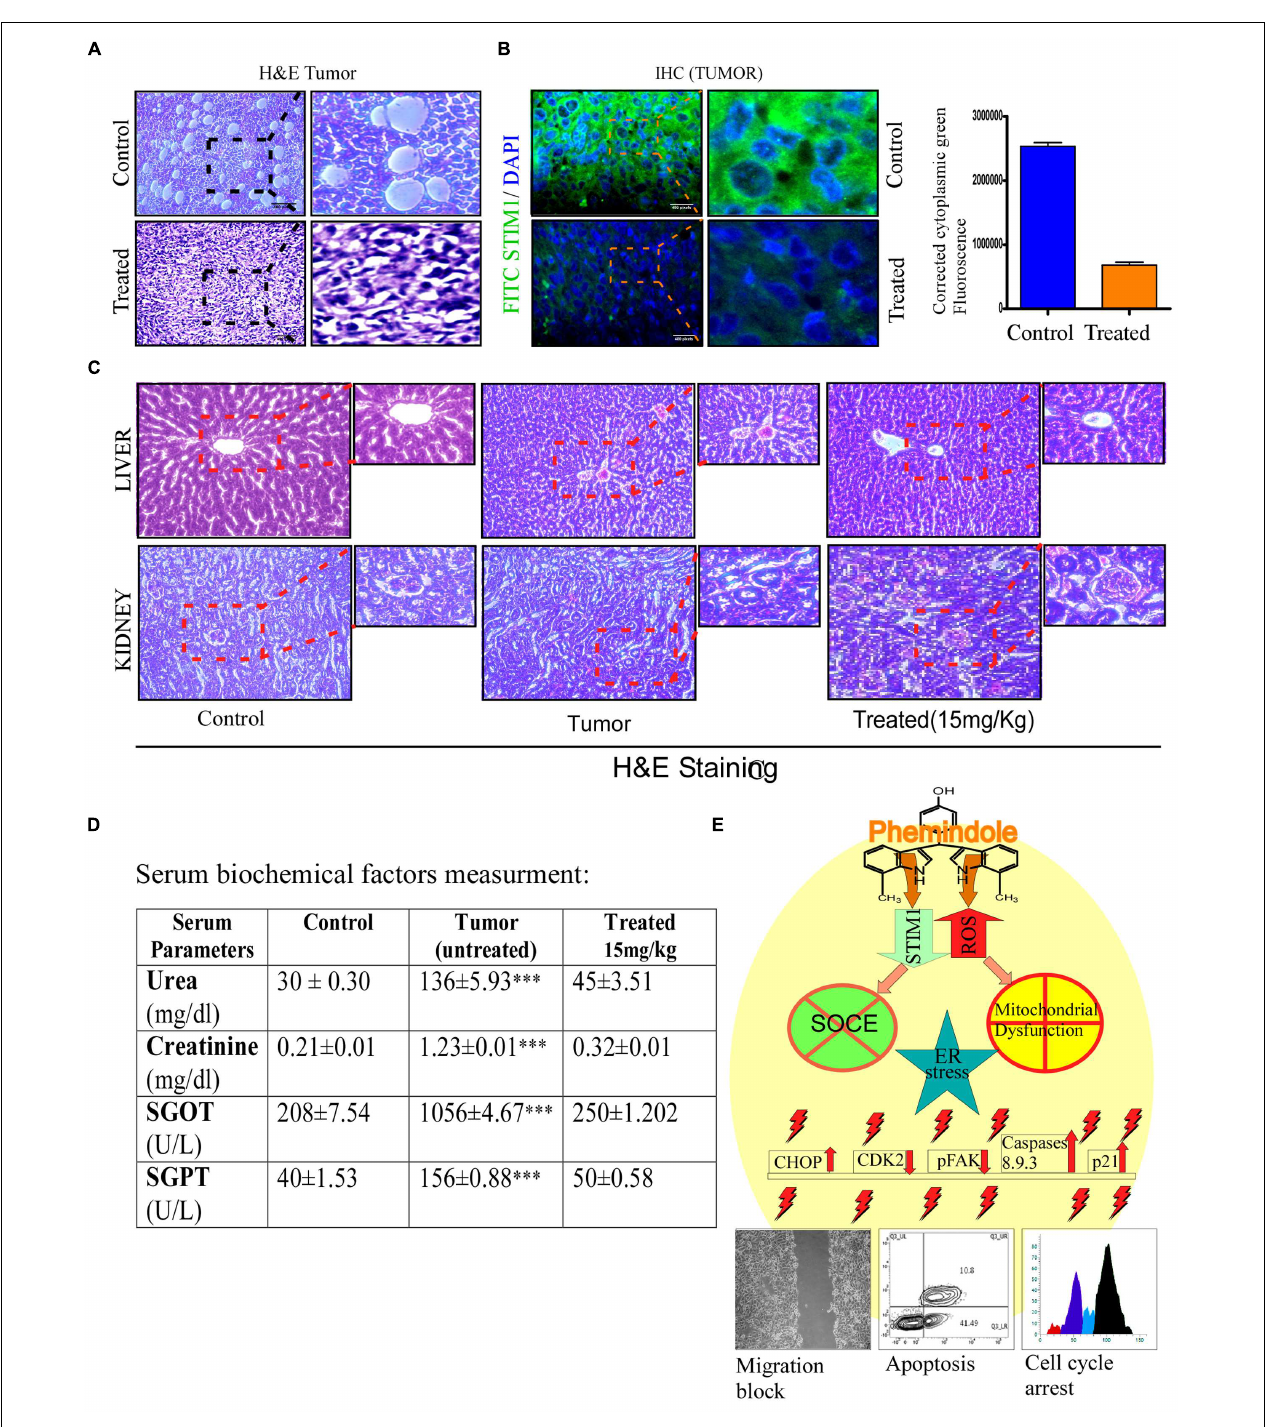
FIGURE 10 | Assessment of toxicity of Phemindole. (A) 4T1 induced tumors excised from the aforementioned sets were analyzed histopathologically using eosin haematoxylin staining and phase contrast images were captured. (B) Immuno-histochemical analysis of the excised tumors from the untreated and Phemindole treated sets using anti-STIM1 antibody (left panel). Corrected Fluorescence intensity of STIM1 protein was quantified and represented as bar diagram (right panel). (C) Histological sections of liver and kidney from the animals were stained with haematoxylin and counter-stained with eosin and microscopically analyzed for histopathologically examinations of tissue toxicity like cellular damage and vacuolization. (D) Blood was collected after sacrifice the mice from control, untreated tumor and Phemindole treated sets and subsequent Liver function test and Kidney Function Test were performed. All measurements of three groups were repeated at least three times, Values are mean ± SEM of three independent experiments in each case or representative of typical experiment. ∗∗∗ P < 0.001, (E) Schematic diagram depicting the detailed molecular mechanisms of antitumorogenic activity of Phemindole against triple negative breast cancer cells.